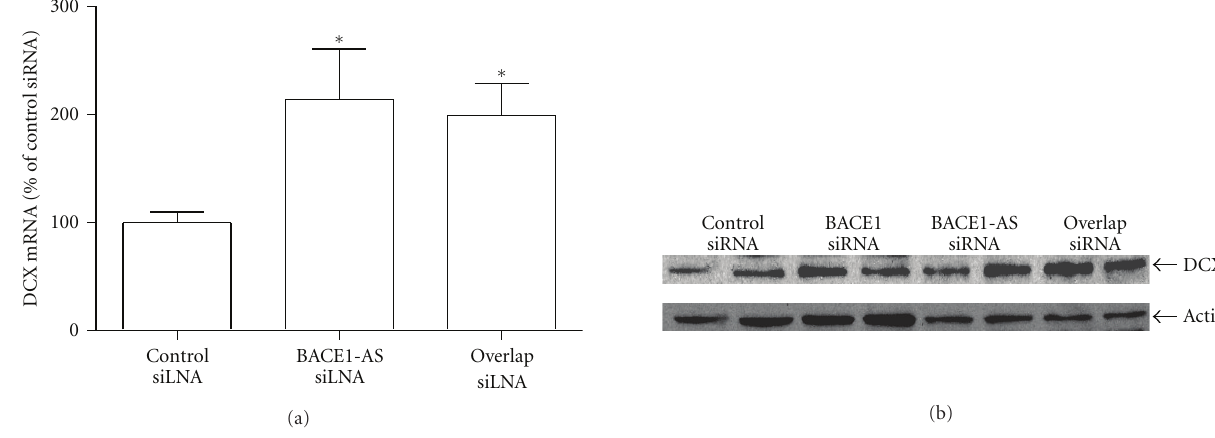
Figure 7: E ff ects of siLNA for BACE1, BACE1-AS, and overlap region in neurogenesis markers in vivo . The infusion of siLNA during two weeks in vivo increased the levels of the neuronal progenitor marker doublecortin (DCX) in both the mRNA (a) and protein (b, duplicates)